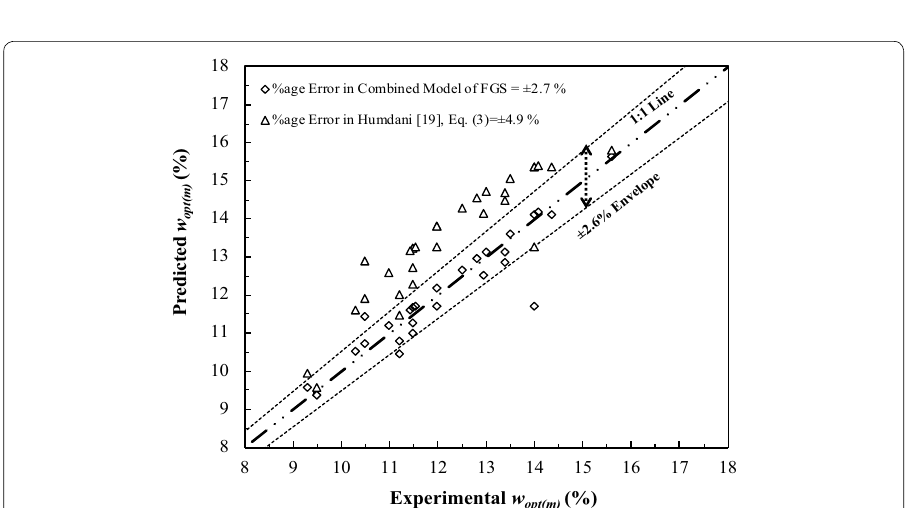
Fig. 13 Comparison of experimental versus predicted values of w opt(m) for combined model and Humdani [20] model based on independent